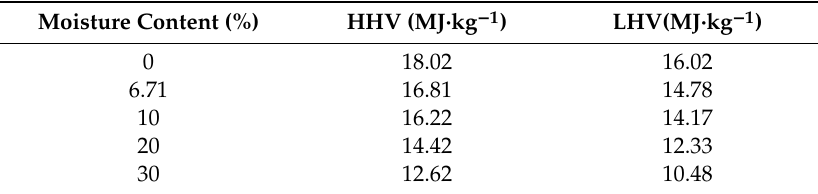
Table 2. HHV and LHV of pellets from tobacco stalks.